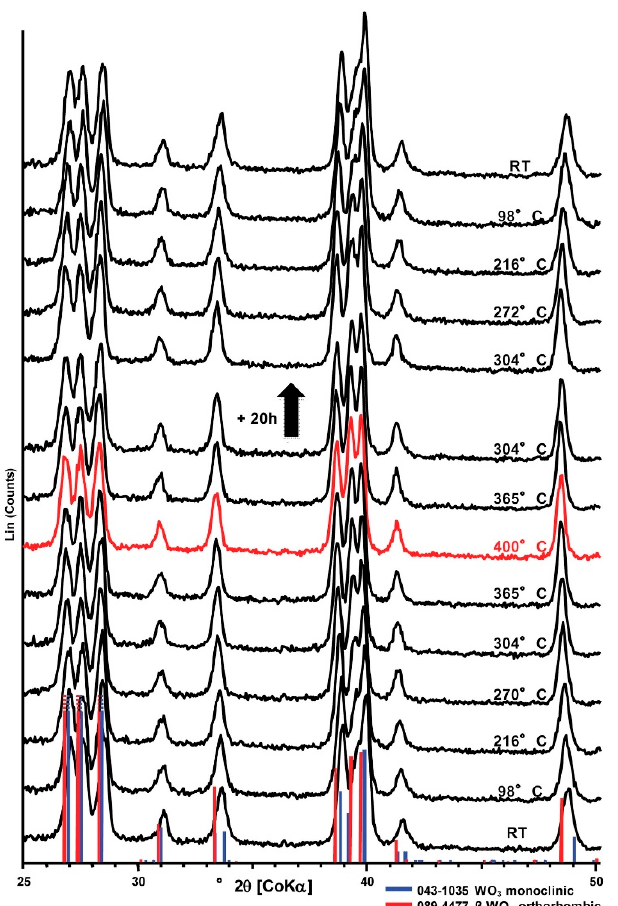
Figure 7. XRD patterns recorded on a WO 3 sample during in situ heating up to 400 °C, followed by holding for 20 h at 304 °C and cooling to room temperature. The phase transition from monoclinic holding for 20 h at 304 ◦ C and cooling to room temperature. The phase transition from monoclinic to orthorhombic at about 300 °C is clearly visible. Reprinted from Sens. Actuators, B: Chem., Vol. to orthorhombic at about 300 ◦ C is clearly visible. Reprinted from Sens. Actuators, B: